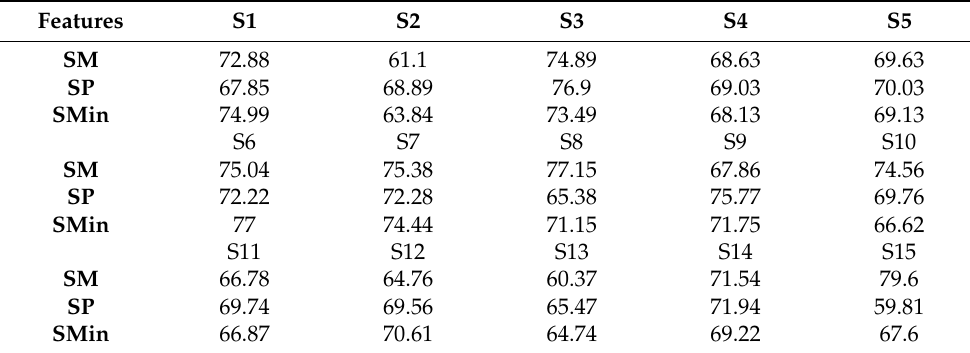
Table 2. Offline classification accuracies of fifteen healthy subjects using single features signal mean (SM), signal peak (SP), signal minimum (SMin) and waveform length features for EMG and fNIRS using LDA and ANN Classifiers.